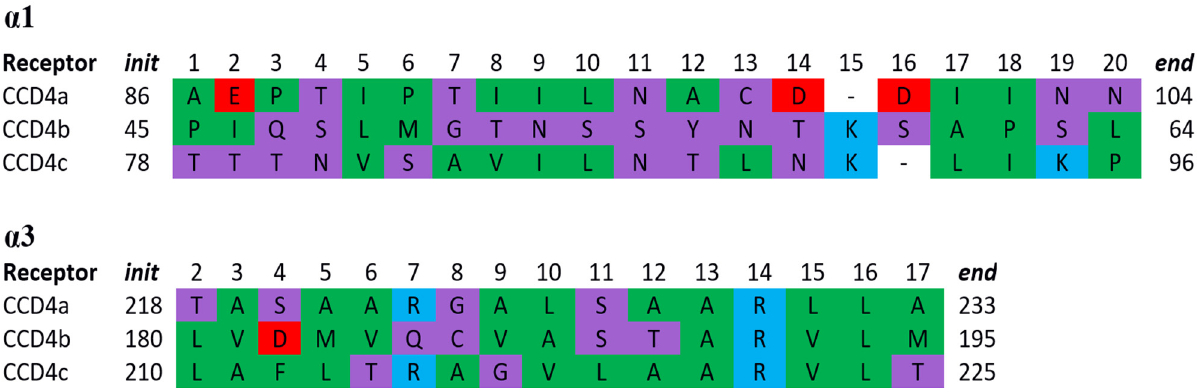
Figure 2. Sequence alignment of the α 1 and α 3 helicoidal regions of CCD4a, b, and c. Colors indicate the degree of polarity of the amino acids: red: negatively charged; blue positively charged; green: hydrophobic; violet: polar. Init and end indicate the initial and final positions of the helical regions in the sequences.